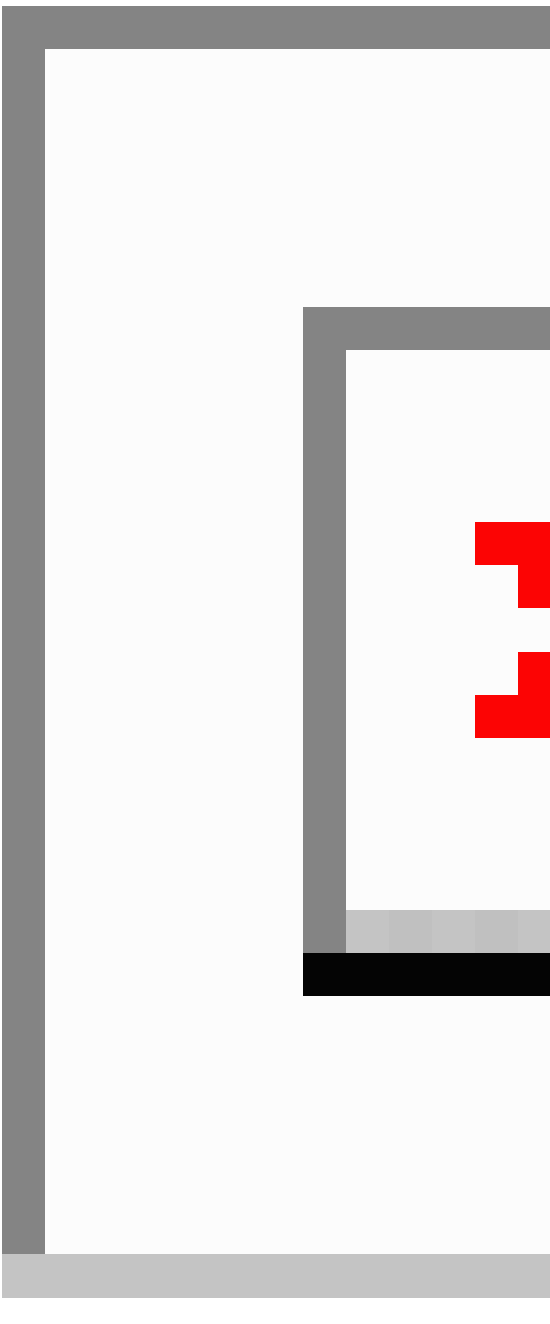
Figure 1. Flow diagram describing the selection process of SRs and